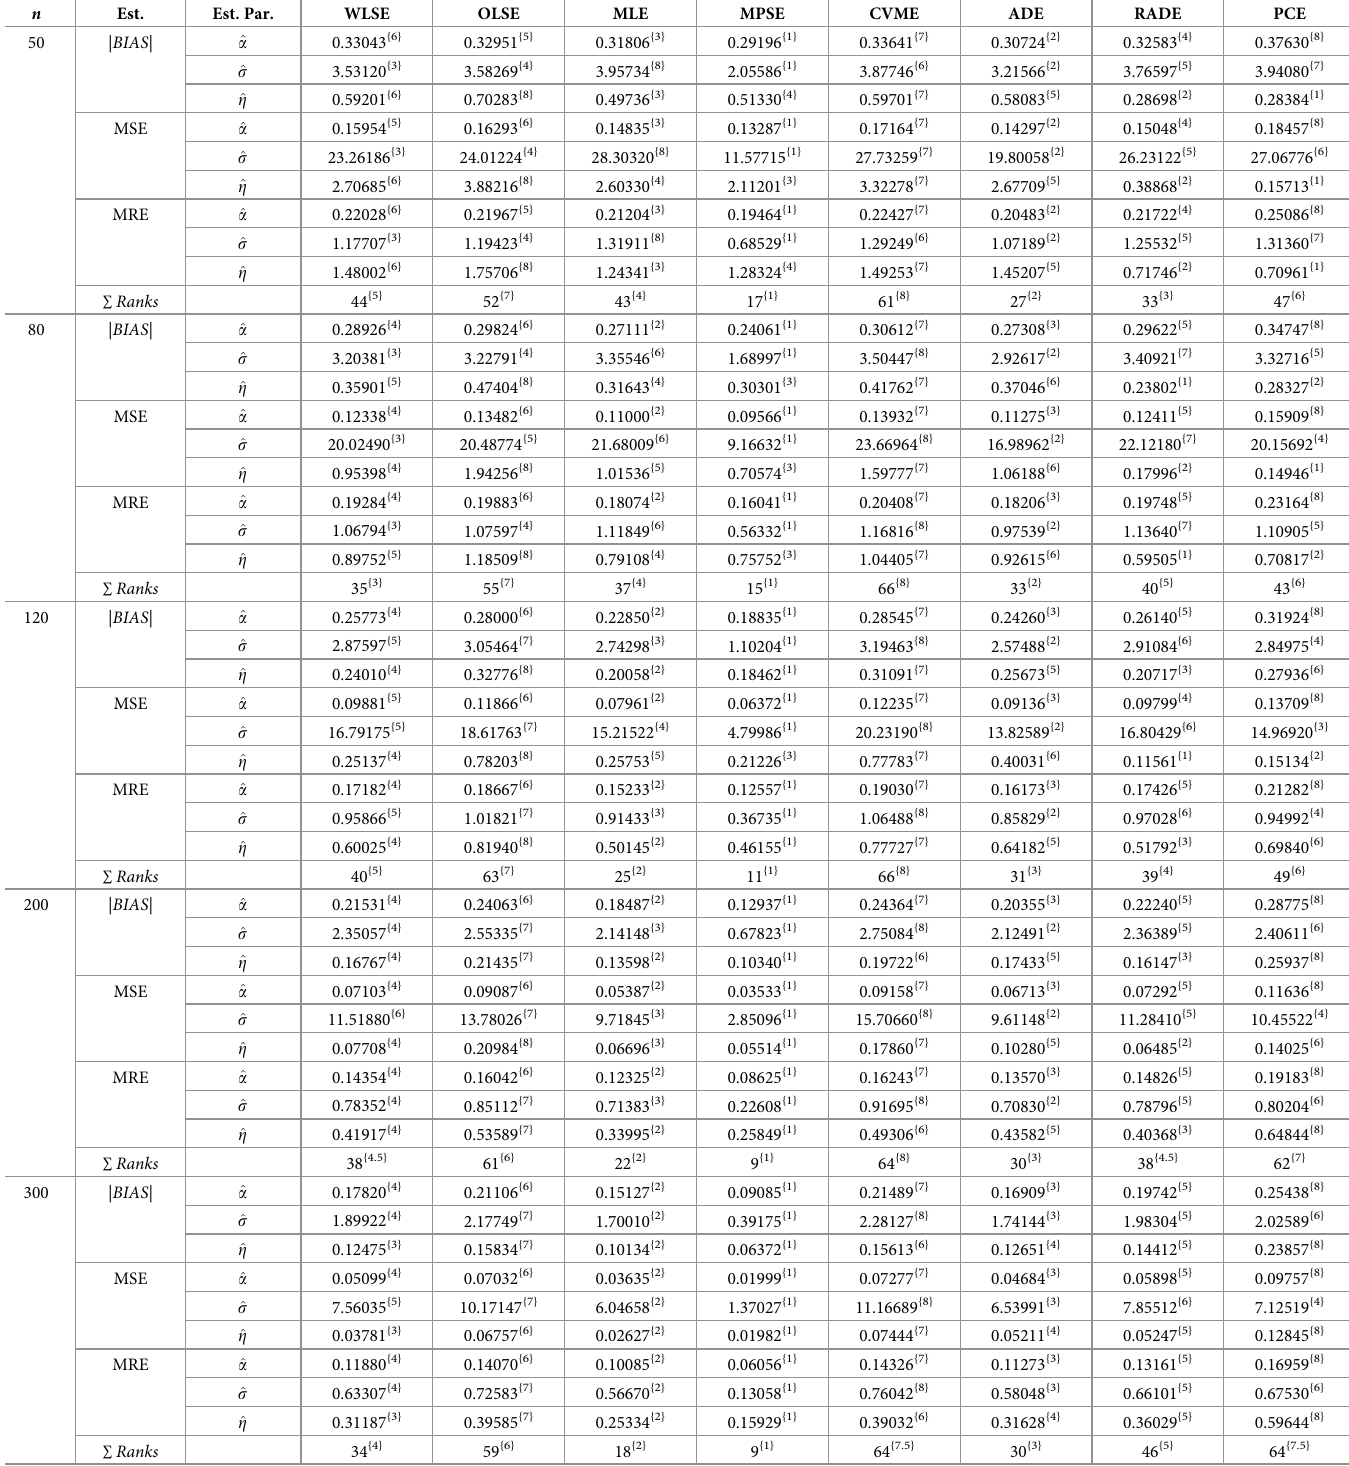
Table 6. Simulation results for Y ¼ ð Z ¼ 0 : 40 ; s ¼ 3 : 00 ; a ¼ 1 : 50 Þ ⊺ . n